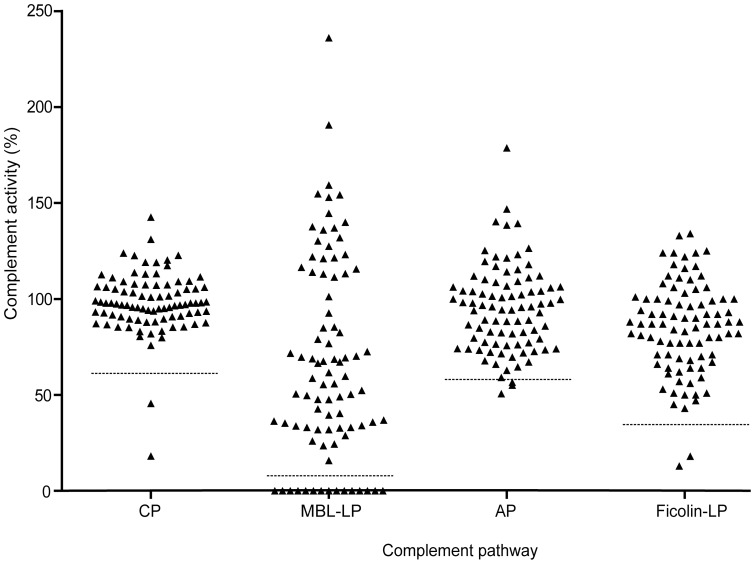
Activity of complement pathways in patients with chronic rhinosinusitis (CRS).The dotted lines indicate the lower cut-off values for normal activity of the given pathway. The cut-off values for the classical, alternative, and Ficolin lectin pathway were defined from the lower limit of a 95% confidence interval. For the MBL lectin pathway the cut-off value was defined as the lowest activity level measured in MBL genotyped donors with at least one structural wild type allele.